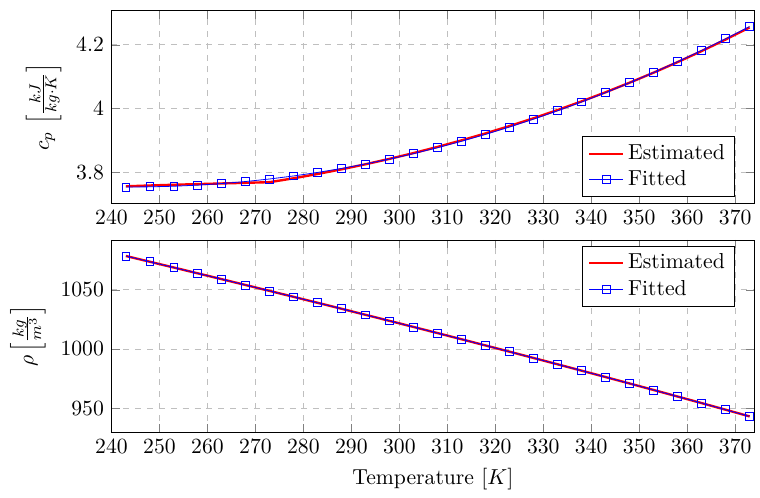
Figure 3. ρ ( T ) and c p ( T ) functions of 25 V % ethylene glycol–water refrigerant. V In the cases of citric acid solubility (Equation (3)), specific heat (Equation (28)), crystal density (Equation (27)) and the specific heat of water (Equation (28)), we used results [21,36] from the literature. The functions have the following